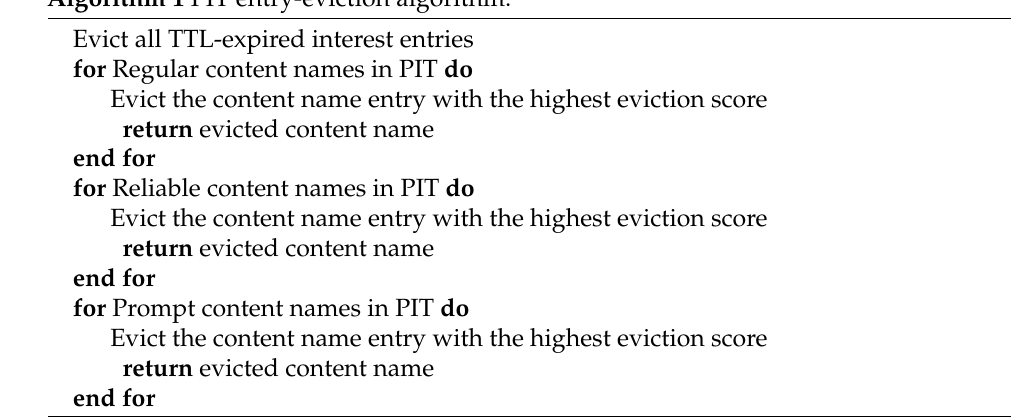
Algorithm 1 PIT entry-eviction